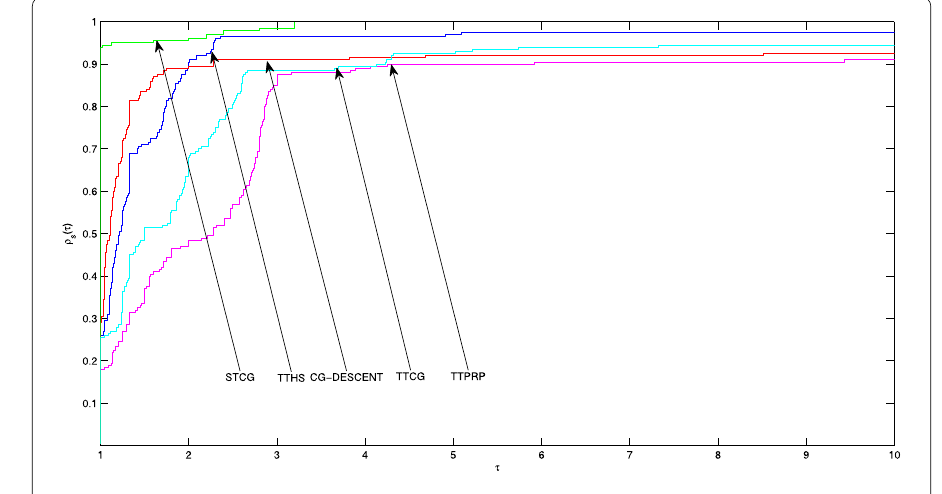
Figure 1 Performance profiles based on iterations.